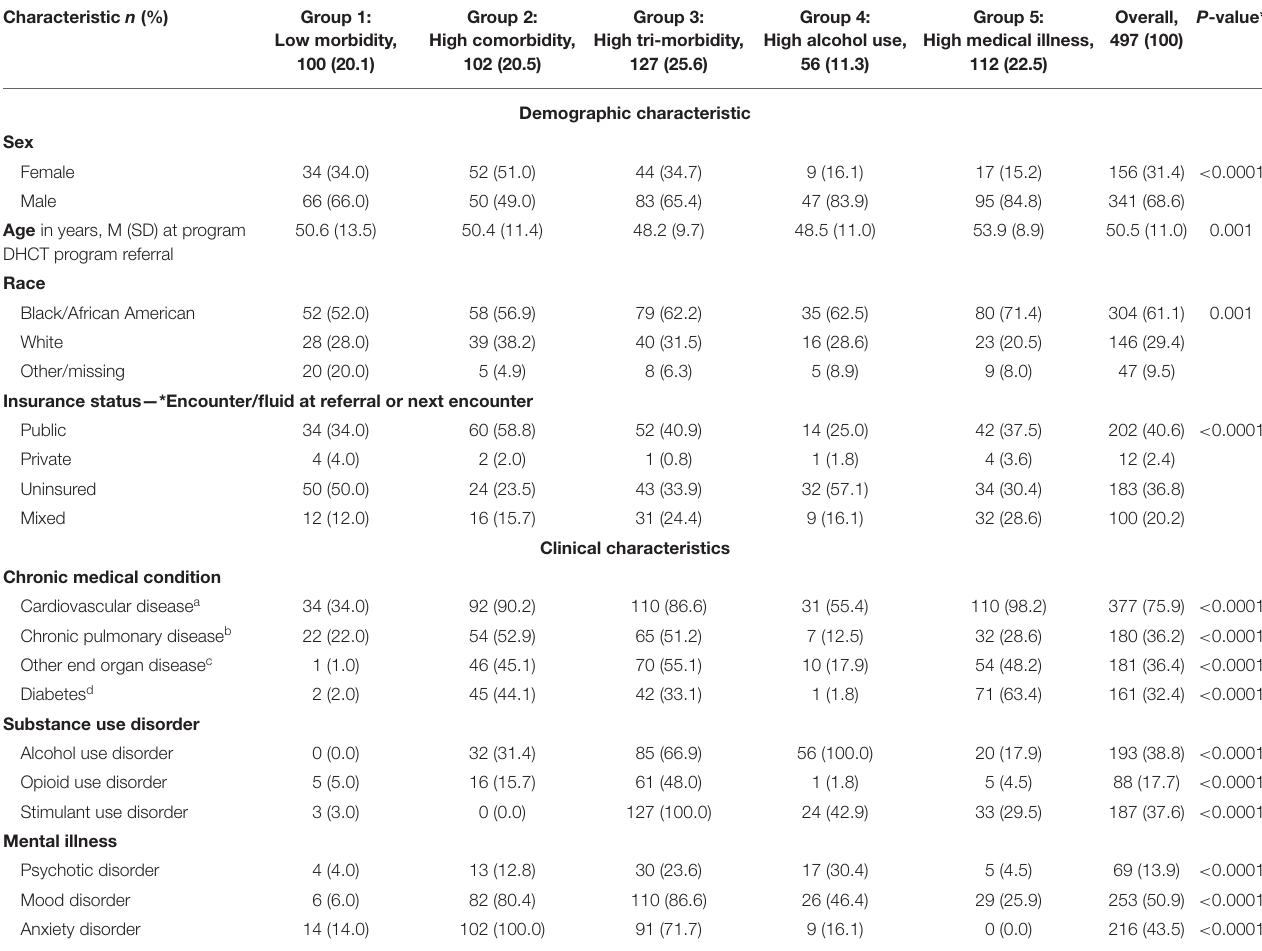
TABLE 1 | Baseline demographic and clinical characteristics of patients referred to DHCT